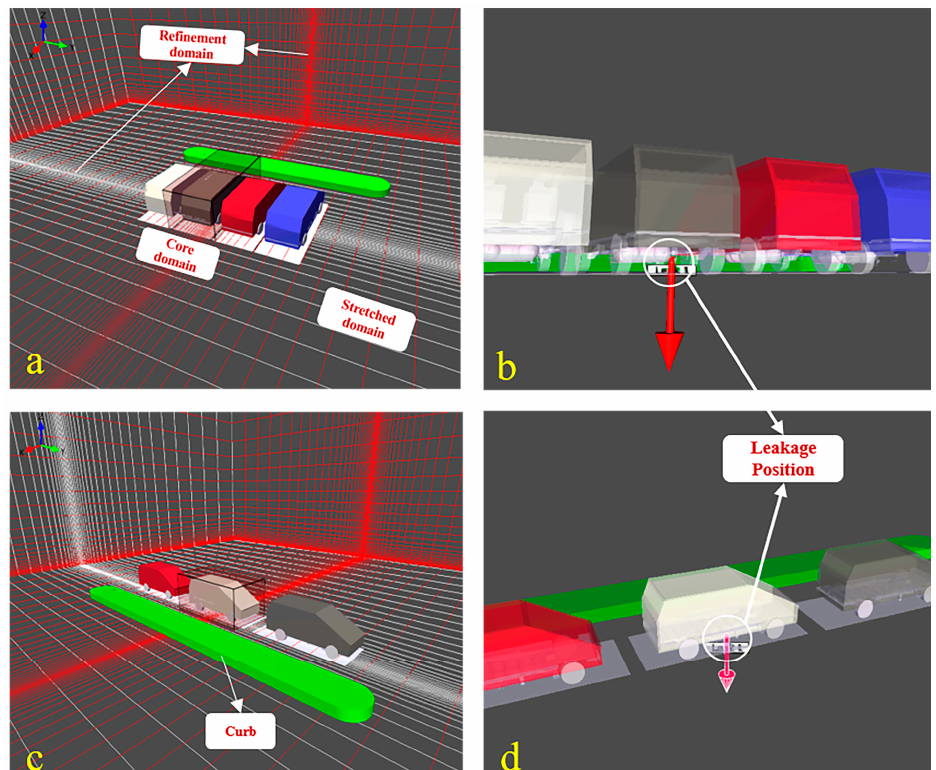
Figure 2. Model of the outside parking garage; ( a ) vertical parking configuration; ( b ) leakage posi- tion in vertical parking configuration; ( c ) parallel parking configuration; ( d ) leakage position in parallel parking configuration.